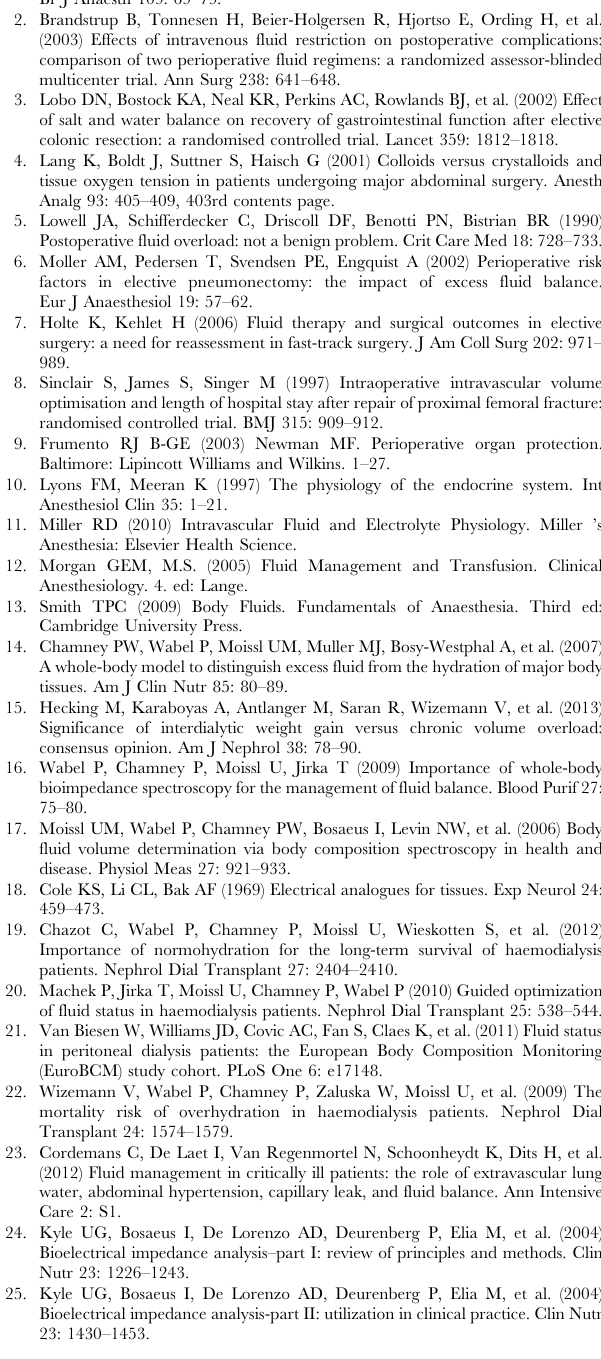
table of contents. 35. Desborough JP (2000) The stress response to trauma and surgery. Br J Anaesth 85: